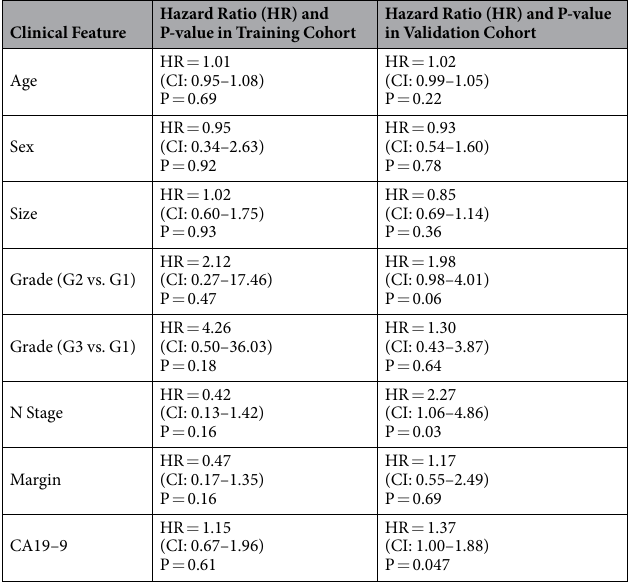
Table 4. List of P-values and hazard ratios for clinical factors for prognosis of OS in the training and validation cohorts. Abbreviations: CI: confidence interval; OS: overall